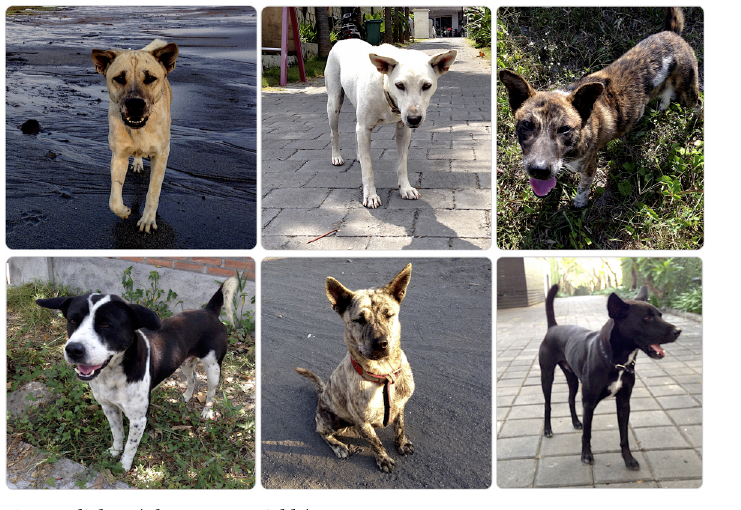
Fig 1. Bali dogs (Photo: Marco